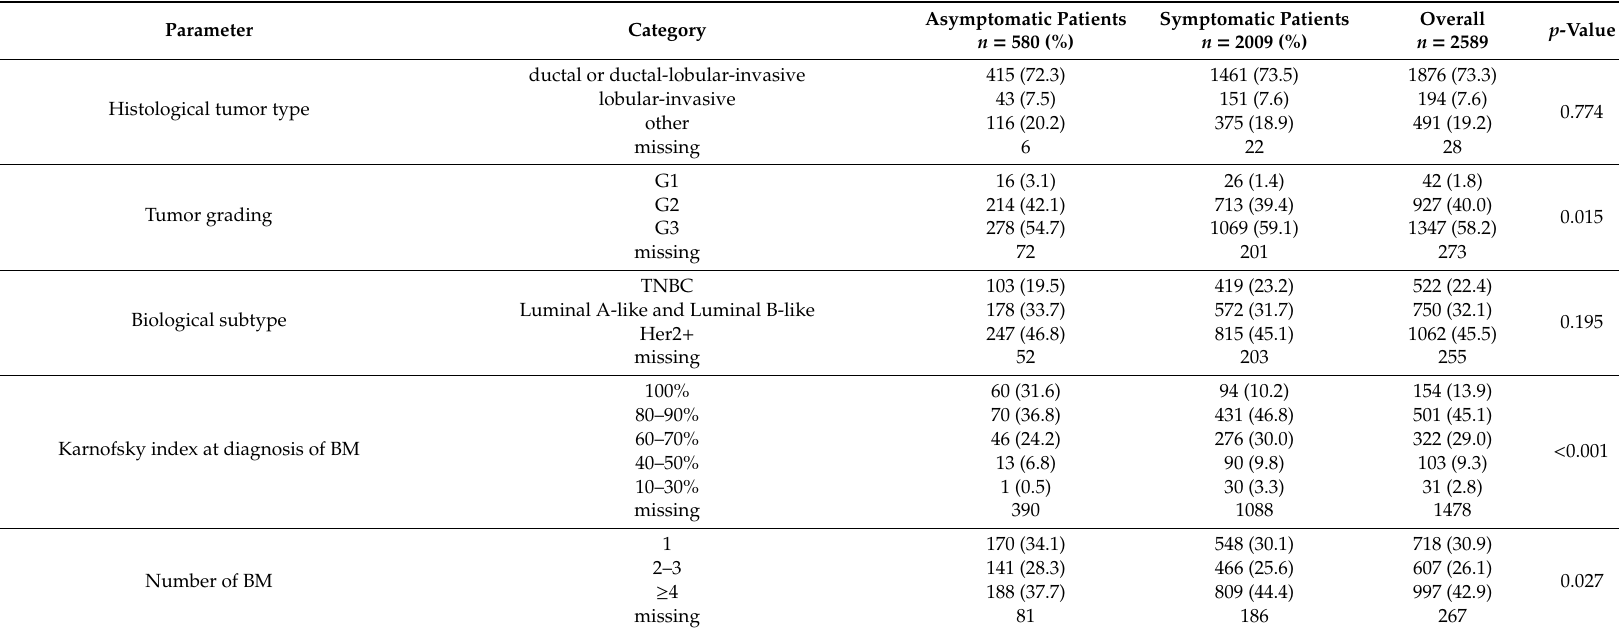
Table 2. Patients’ characteristics, categorical